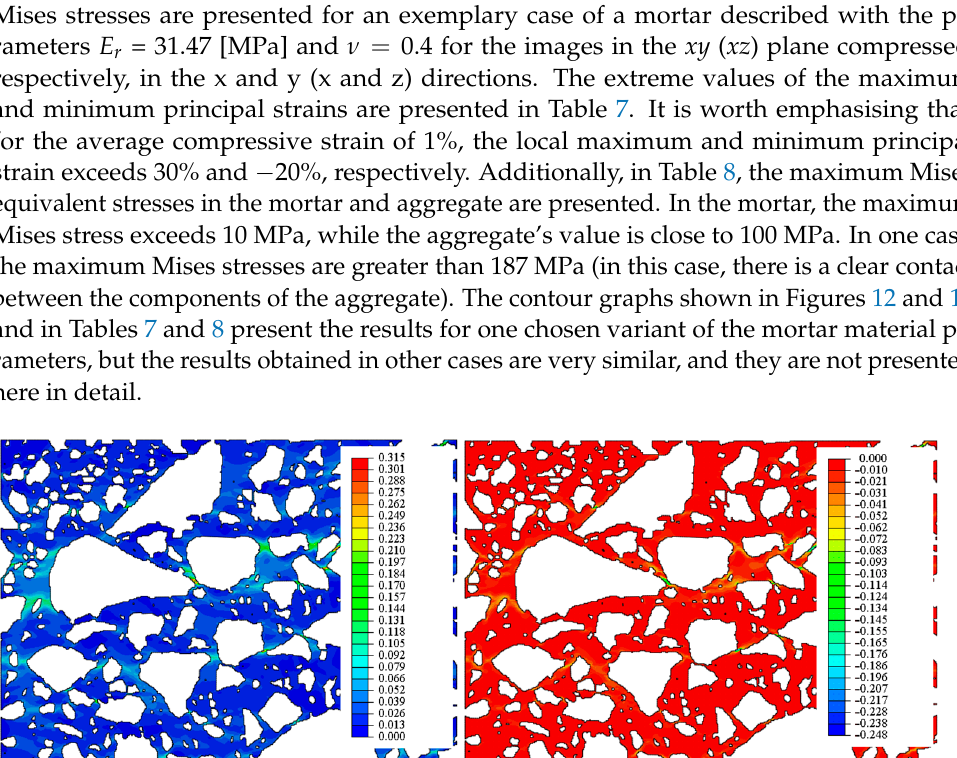
( b ) Figure 13. Contour graphs of the equivalent Mises stresses in ( a ) mortar and ( b ) aggregate. 5.2. The Influence of the Poisson Ratio For these calculations, the mortar’s material data are selected as in the second row of Table 3. Figure 14 contains the effective stiffness moduli